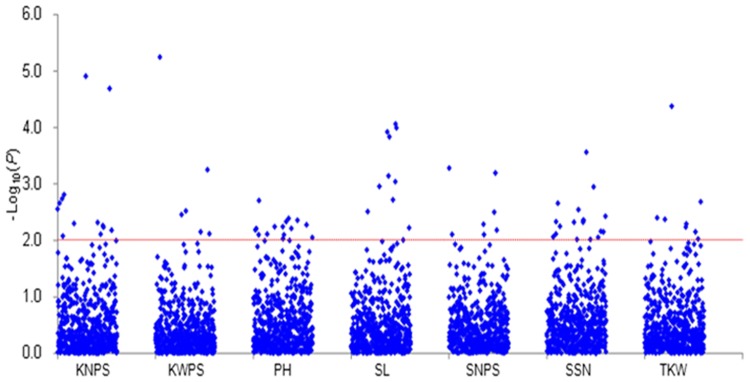
Associations of seven phenotypic traits with 106 genome-wide SSR markers illustrated as dot plots of compressed MLM at P<0.01.The red dotted line indicates the threshold value of significant association.